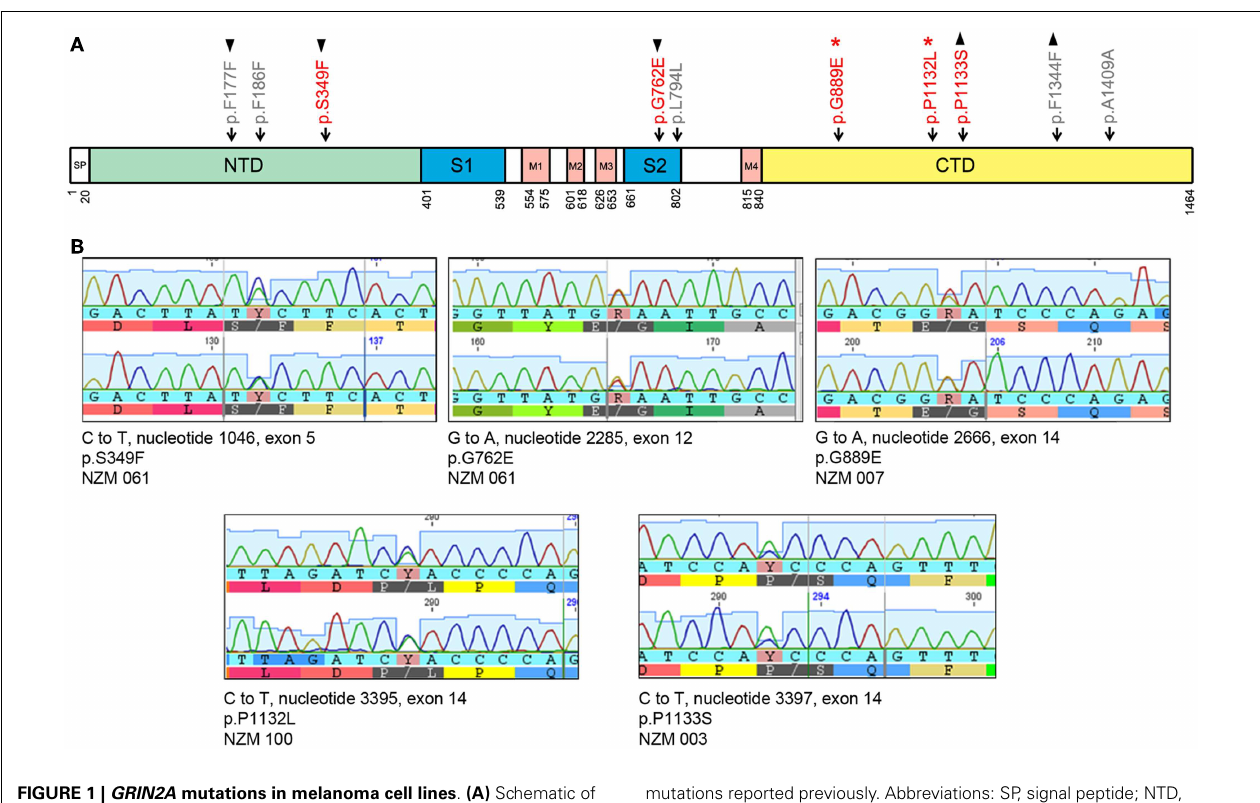
FIGURE 1 | GRIN2A mutations in melanoma cell lines . (A) Schematic of the GluN2A protein together with the non-synonymous (in red) and synonymous (in gray) mutations in GRIN2A . GRIN2A cDNA is 4392 nucleotides long and can be divided into sections encoding evolutionarily conserved domains in the GluN2A protein.The first and last amino acid residues of the SP, S1, S2, and M1–M4 domains are numbered. Symbols (cid:78) and (cid:72) mark mutations that coincided in the same tumor samples;